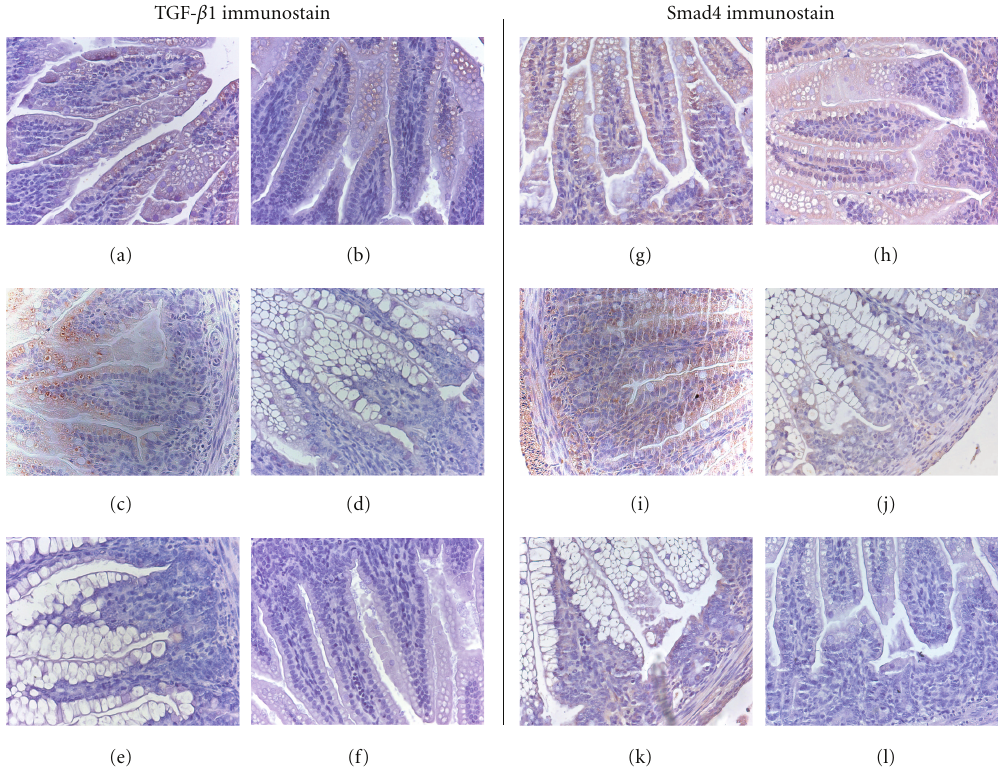
Figure 4: Mucosal immunolocalization of TGF- β 1 and Smad4 in DR and FF pups at day 14 with or without daily/intermittent treatment with OVA. Representative images are shown for all groups. Positive staining is indicated as a brown color. TGF- β 1 (a–f: DR (a), DR + OVA c (b), DR+OVA i (c), FF (d), FF+OVA (e), and negative control (f)) and Smad4 (G-L: DR (g), DR+OVA c (h), DR+OVA i (i), FF (j), FF+OVA (k), and negative control